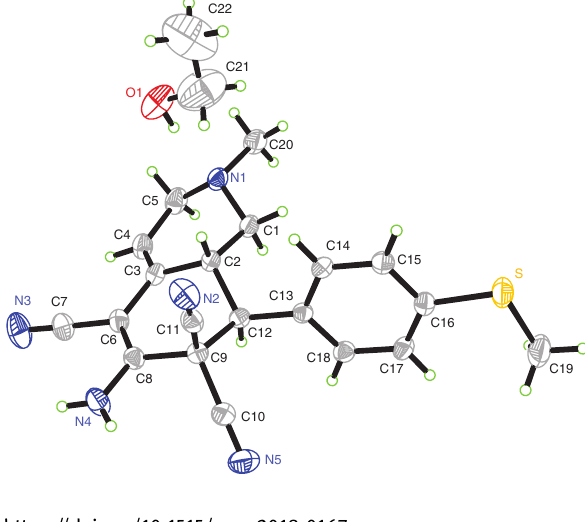
Table 1: Data collection and handling.